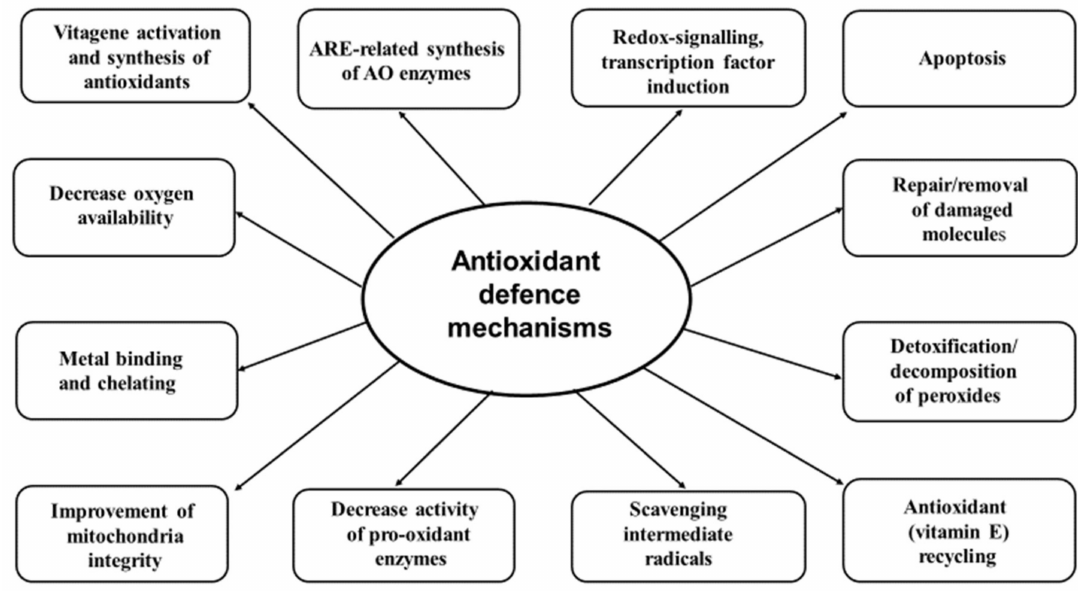
Figure 1. Antioxidant defence mechanisms (adapted from Reference